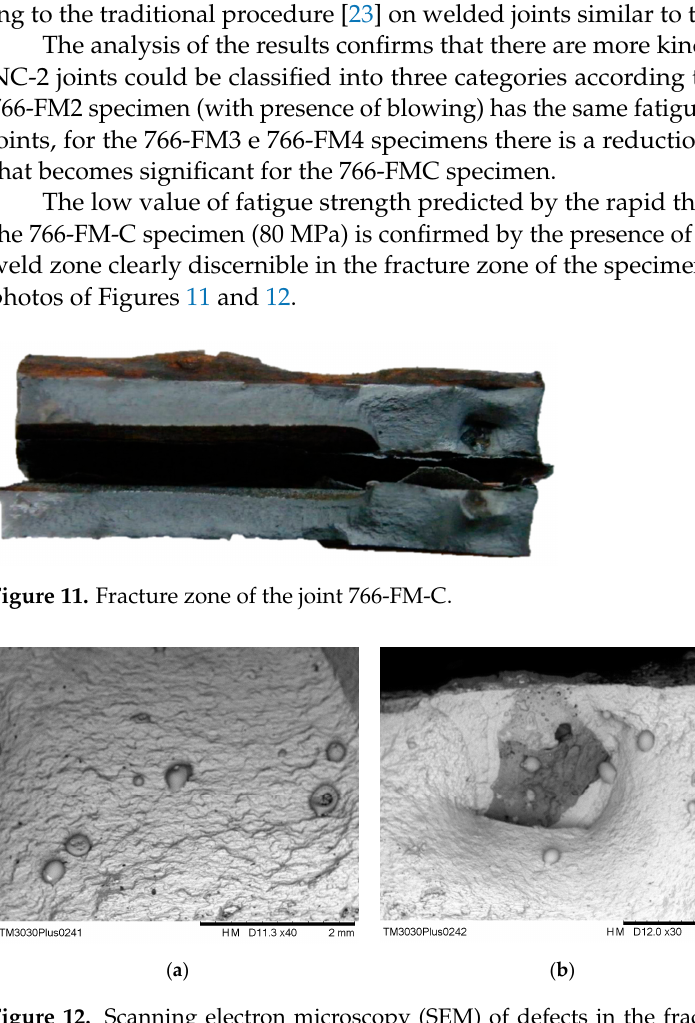
( c ) Figure 13. SEM of defects in the fracture zone of the specimen 766-FM2: ( a ) inclusions; ( b ) worm holes and ( c ) void in the propagation area.